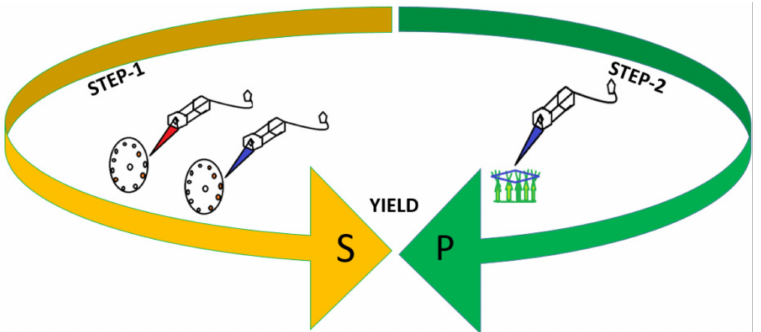
Figure 1. Complementary plant biostimulation. Positive synergistic effect of combining pre- emergence biostimulation of seeds with post-emergence biostimulation of plants.